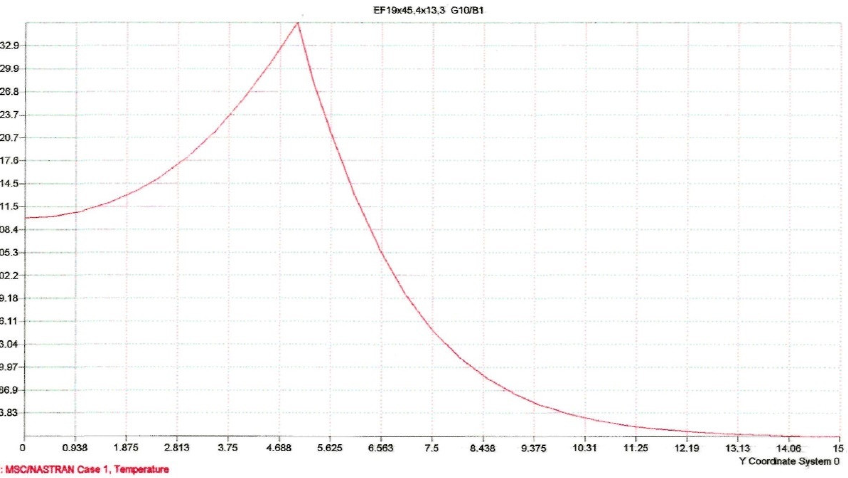
Figure 14. Thermal loading of the rings for EF19 × 45,4 × 13,3, G10/B1, along the interface.